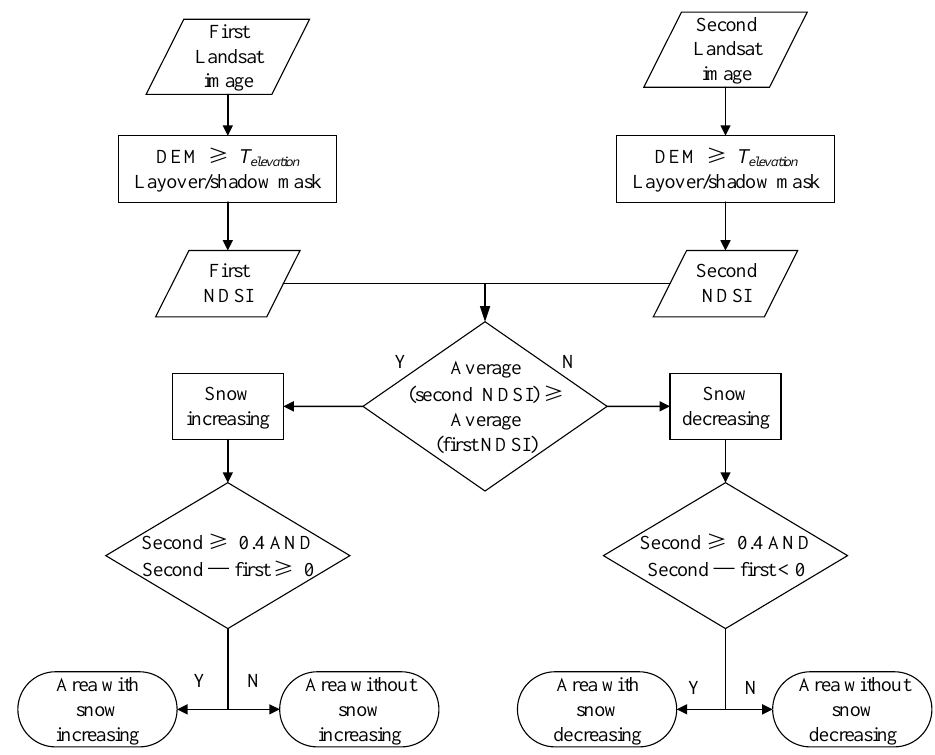
Figure 9. Areas with the snow increase in an accumulation period or the snow decrease in a snowmelt period.